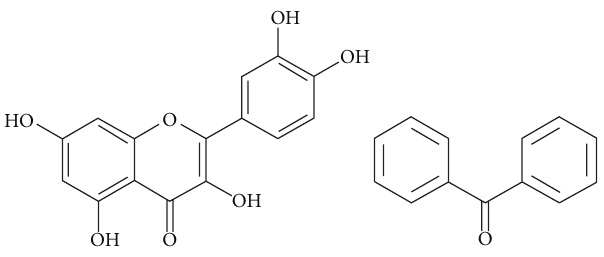
Figure 1: Structures of quercetin (left) and benzophenone